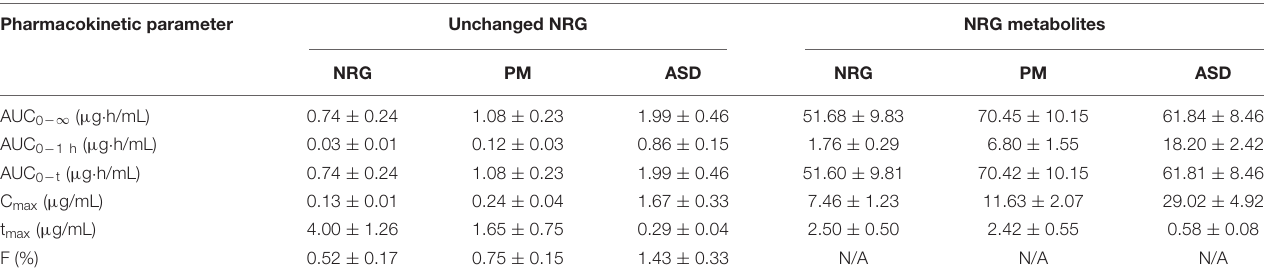
TABLE 1 | Pharmacokinetic profiles of crystalline NRG, PM, and NRG SD orally administered to rats. Pharmacokinetic